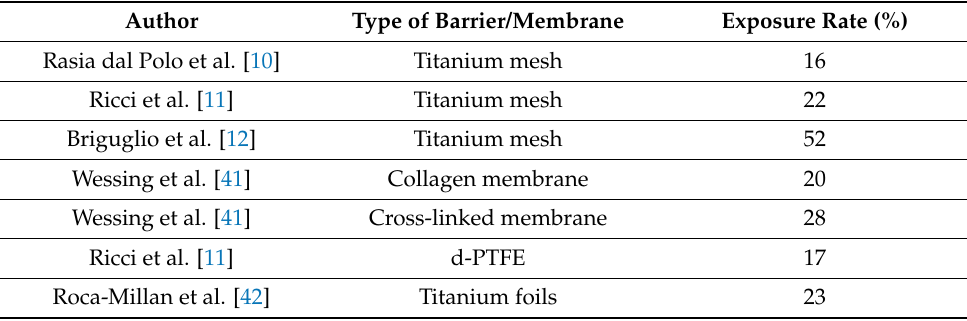
Table 6. Incidence of membrane/barrier exposure in different